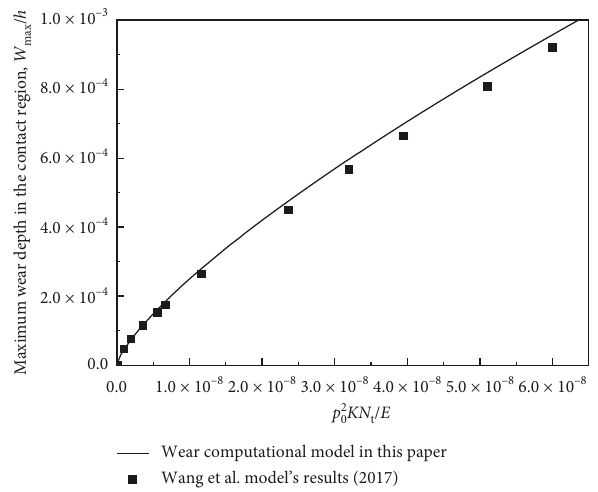
Figure 8: Validity of the fretting wear life computational